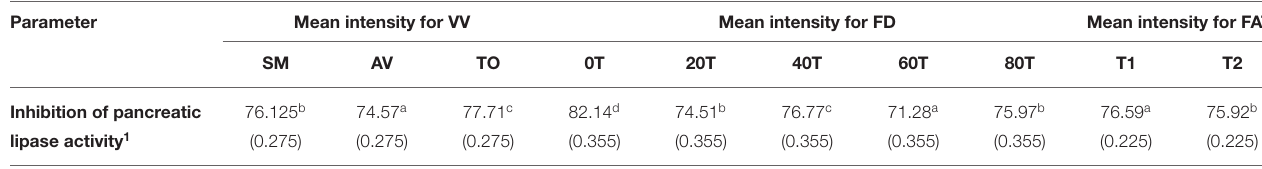
TABLE 2 | Results from 3-way ANOVA and Duncan’s test of the effects of vegetable variety, (VV); fertilizer dose, (FD); fertilizer application time, (FAT): T1 at planting, T2 after planting; Telfairia occidentalis , (TO); Solanum marcrocarpon , (SM); Amaranthus viridis , (AV); (0T-80T as fertilizer dosing treatments) on pancreatic lipase inhibitory activity of vegetable